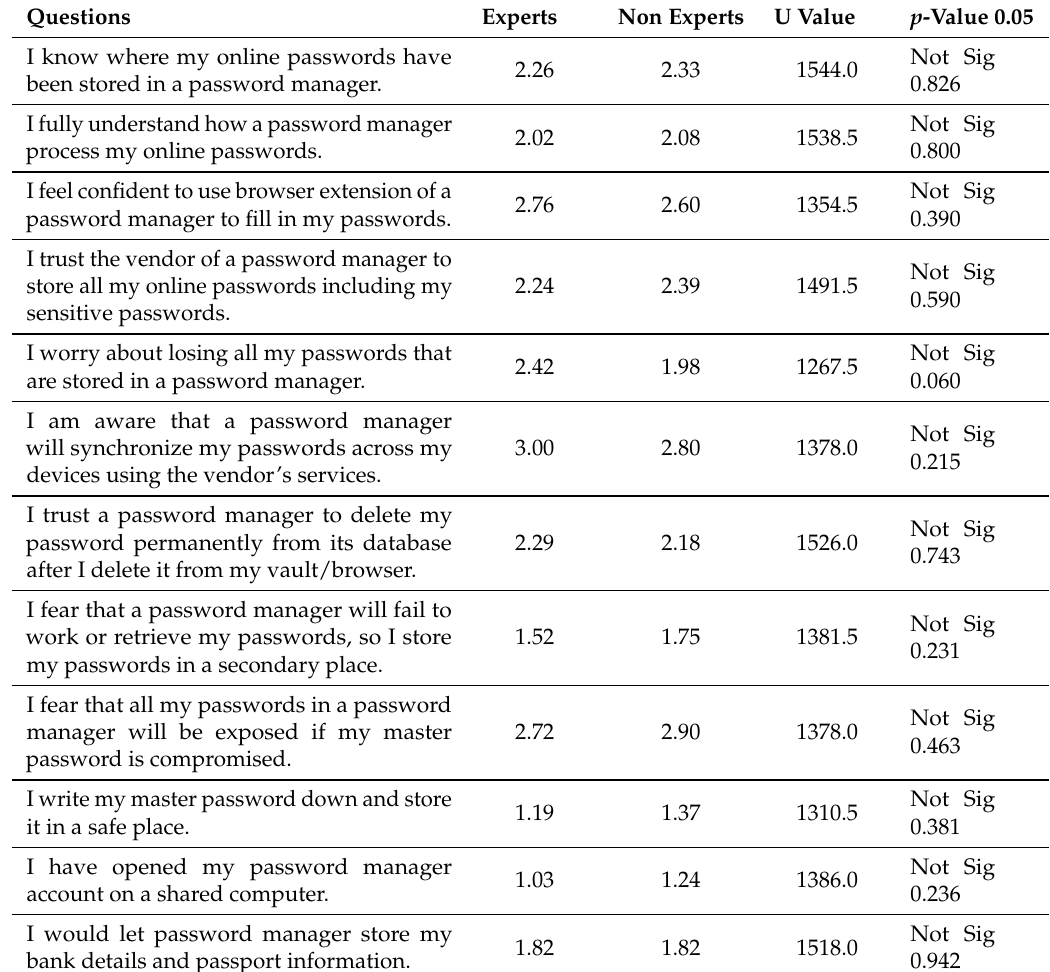
Questions Experts Non Experts U Value p -Value